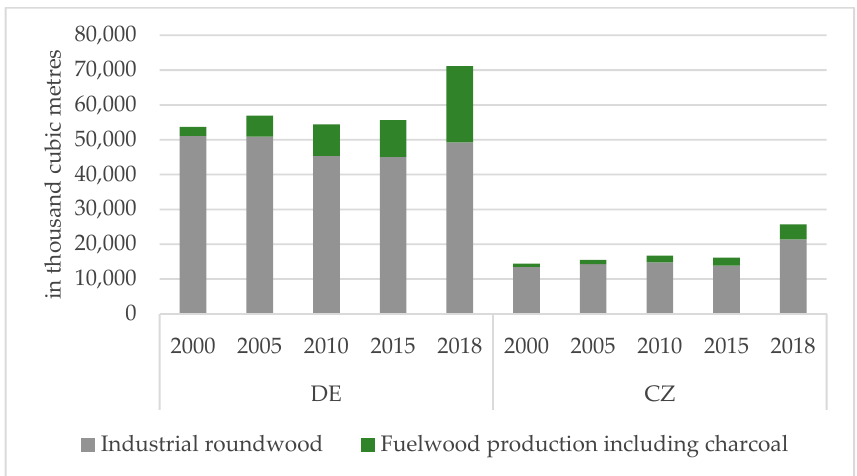
Figure 3. Industrial roundwood and fuelwood production in Germany (DE) and the Czech Republic (CZ) (2000–2018) [43].